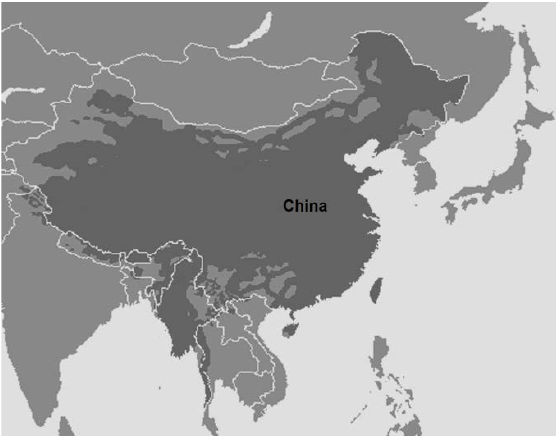
Fig. 4. A map of the Sino-Tibetan languages (dark gray